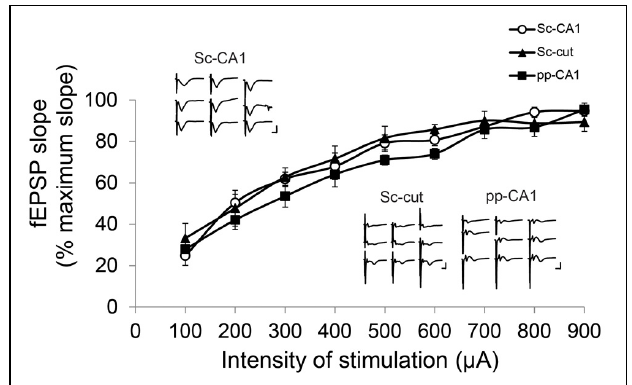
FIGURE 3 | Input/Output characteristics for the Sc-CA1, pp-CA1, and Sc-cut synapse. The fEPSP slope was recorded as the maximum slope from the beginning of the potential to the first minimum value for each subject. For each intensity of stimulation the values are expressed as percentage of the highest value obtained. There was no significant difference between Sc-CA1, SC-severed (Sc-cut) or pp-CA1 groups ( n = 8 for Sc-CA1, n = 8 for Sc-cut and n = 9 for pp-CA1). Typical evoked responses from Sc-CA1, Sc-cut, and pp-CA1 animals embedded in the chart. Increasing the stimulation intensity stepwise (100–900 μ A, step size 100 μ A) complicated the analysis of the fEPSPs from the pp-CA1 and Sc-cut synapse to same extent. Vertical scale bar: 3mV, horizontal scale bar: